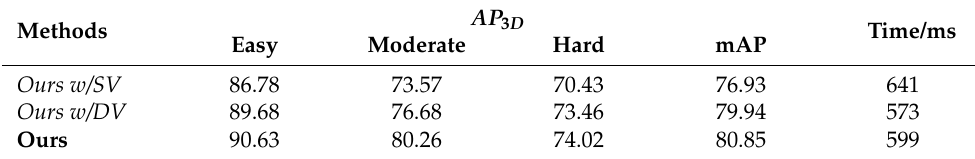
Table 5. The ablation study of point cloud processing method on car category (%).